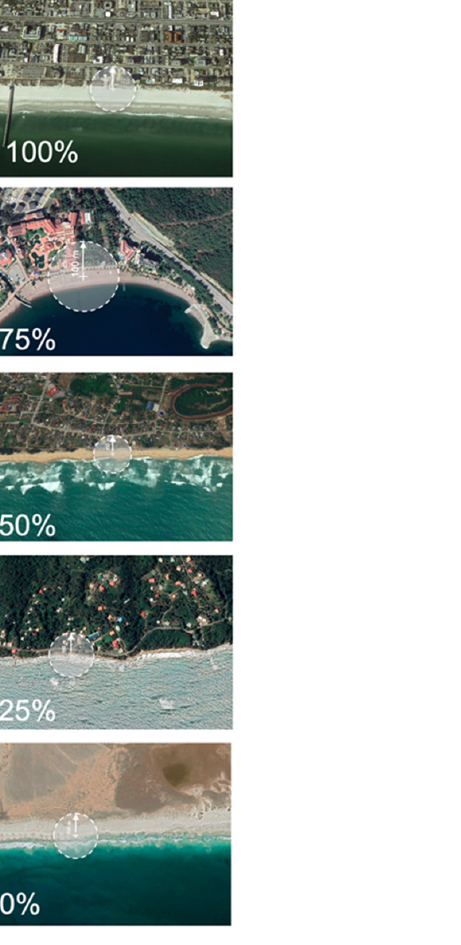
Figure 1. Google Earth imagery demonstrating the extent of hard anthropogenic coastal development (HACD), forming barriers to the landward retreat of beaches scored as 0%, 25%, 50%, 75%, and 100%, and higher resolution examples of HACD. White circles indicate schematic representation of scoring, where HACD within 100 m of the survey point was enumerated.